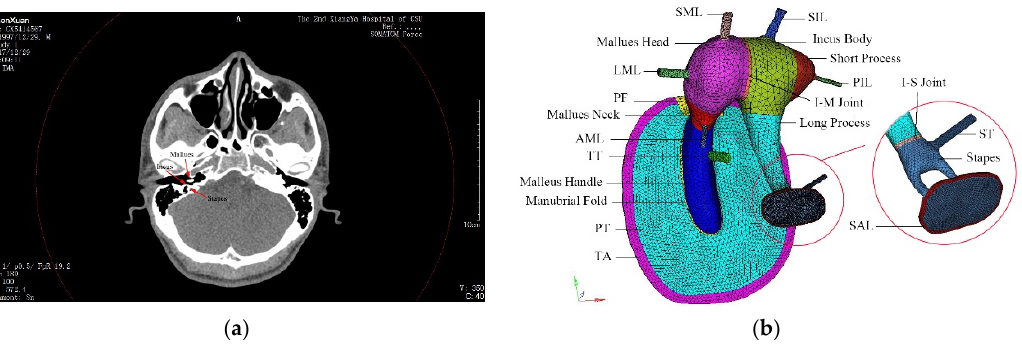
Figure 1. Human middle ear biomechanical finite element model; ( a ) ossicle bones on head computed tomography (CT) scanning; ( b ) ear model. Note: TA: tympanic annulus, PT: pars tensa, PF: pars flaccida, TT: tensor tympani, AML: anterior mallear ligament, LML: lateral mallear ligament, SML: superior mallear ligament, I-M joint: incudomalleolar joint, SIL: superior incudal ligament, PIL: posterior incudal ligament, ST: stapedial tendon, SAL: stapedial annular ligament.